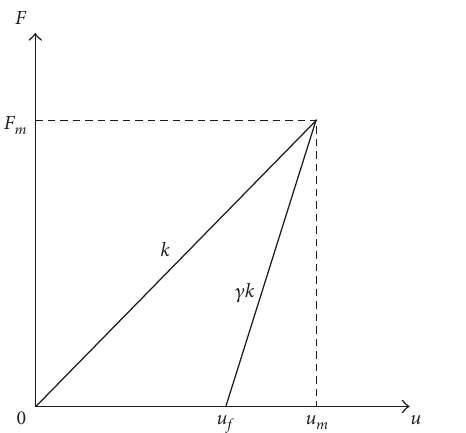
Figure 3: Force versus penetration relationship representing the bit–rock interaction